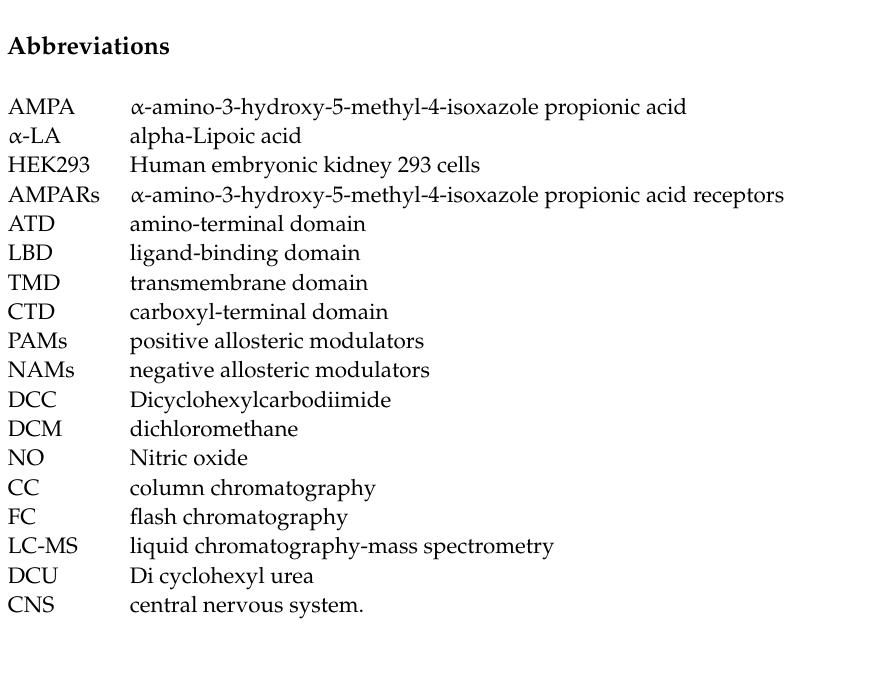
concentrations steadily climbed from 2 µ M to 12 µ M as the LA derivatives were applied to the subunit. The whole-cell current was measured at − 60 mV, pH 7.4, and 22 ◦ C; Figure S3: Characterization of Lipoic acid; Figure S4: Characterization of Lipoic acid of 1-hydroxy-3- lipo ester (LA-PRO-OH) LA1; Figure S5: Characterization of 1-hydroxy-6-lipoester (LA-HEX-OH) LA4; Figure S6: Characterization of Nitrooxy–propane-3-lipoyl ester (LA-PRO-ONO2) LA2; Figure S7: Characterization of 1-Nitrooxy– Hexane-6-lipoyl ester (LA-HEX-ONO2) LA3; Figure S8: Effect of dichloromethane on GluA1 and GluA2 subunits. Graphs a–d demonstrates the effects of dichloromethane on GluA1 and GluA2 whole-cell current, as well as the rates of deactivation and desensitization. Cells were treated with 12 µ M dichloromethane at a concentration comparable to that of the LA derivatives; Table S1: Whole- Cell Recordings for Compound α -LA, ** p < 0.01; *** p < 0.001; Table S2: Whole-Cell Recordings for Compound LA1, *** p < 0.001; Table S3: Whole-Cell Recordings for Compound LA2, *** p < 0.001; Table S4: Whole-Cell Recordings for Compound LA3, * p < 0.05; *** p < 0.001; Table S5: